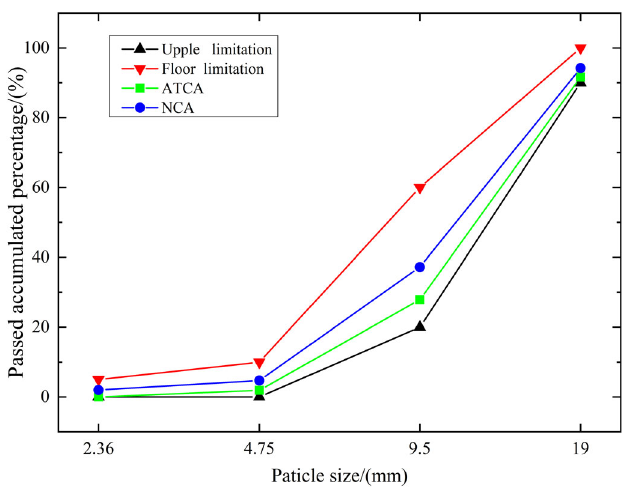
Figure 9. Gradation curve of ATCA and NCA. Table 3. The test results of density, water absorption and ASR.